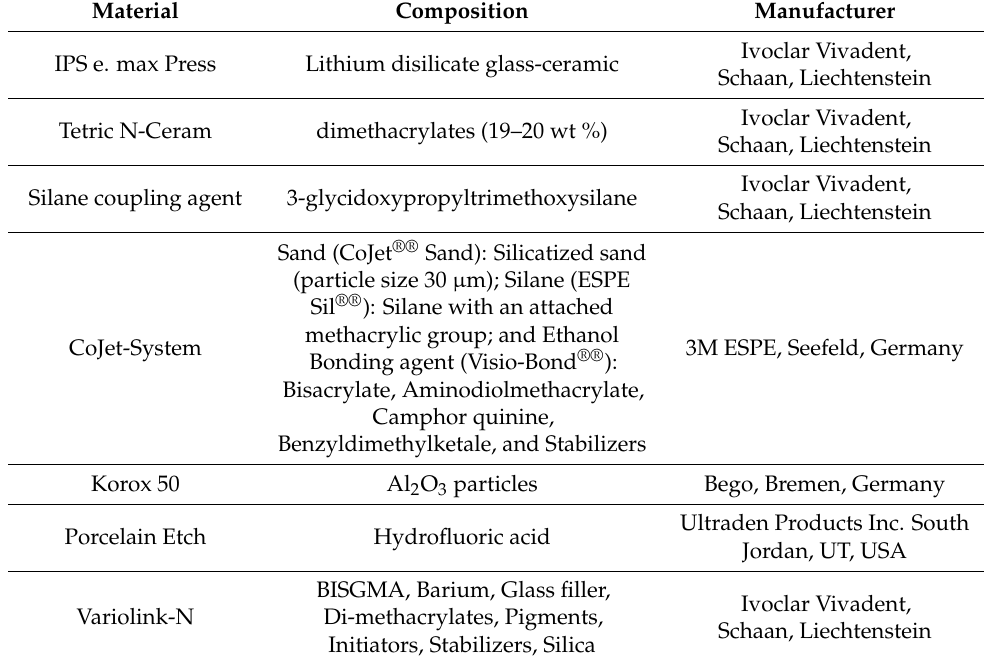
Table 1. Materials used in the study.